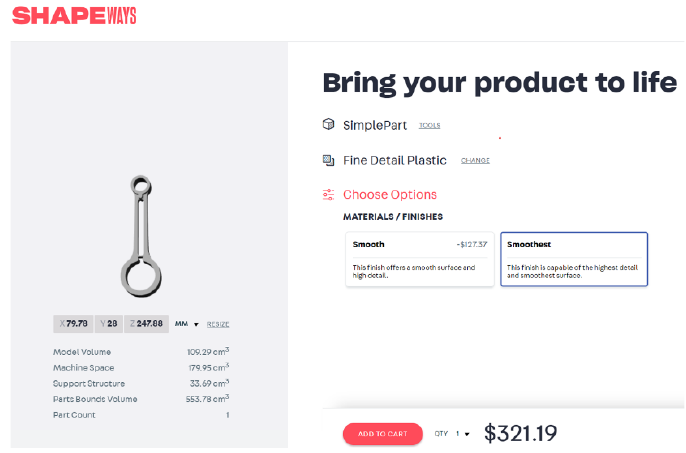
Figure 1. Shapeways platform estimating build cost for a part.